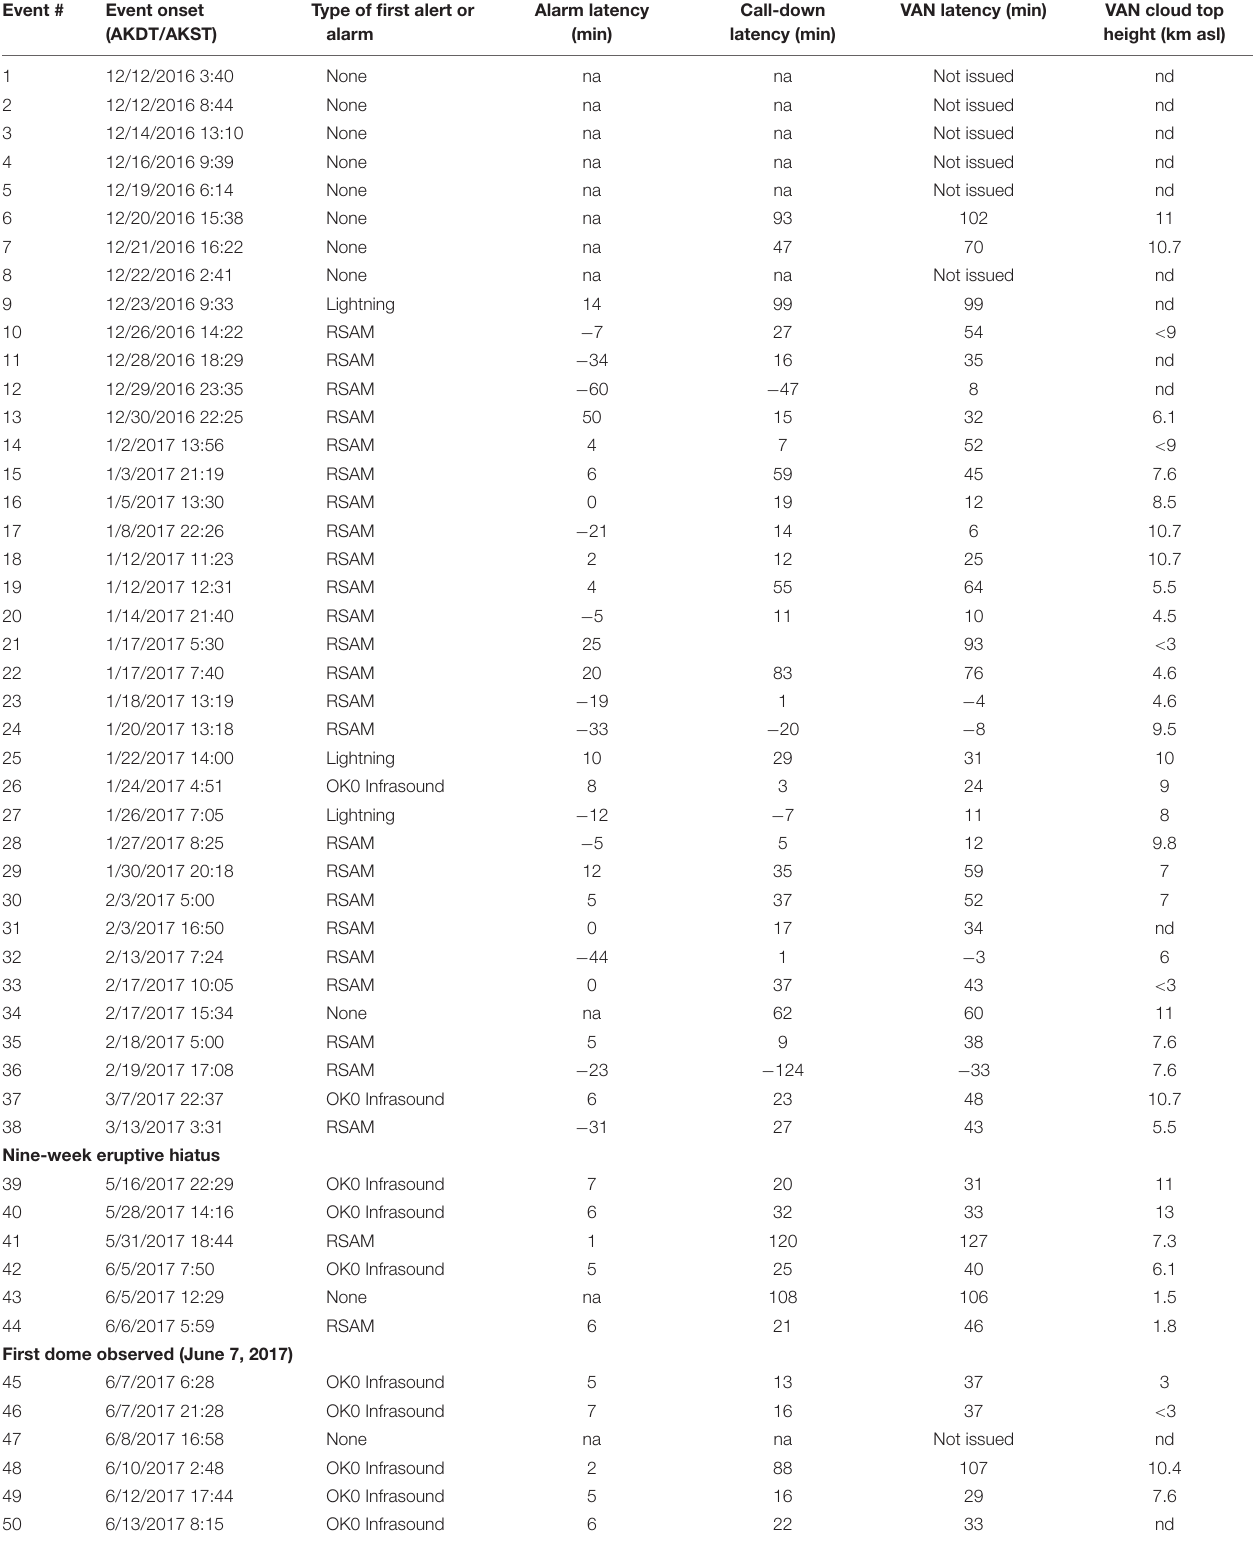
TABLE 1 | Explosive events during the 2016–2017 eruption of